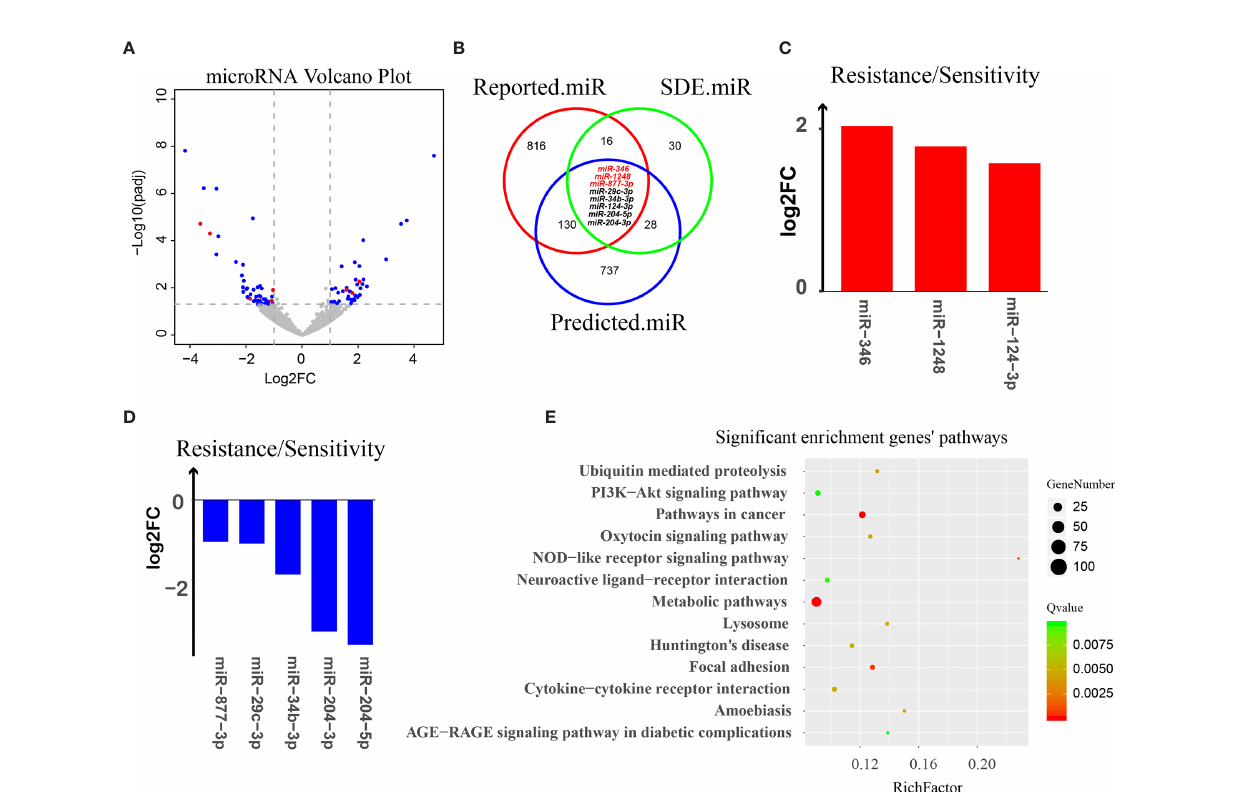
FIGURE 5 | Analysis of miRNA targeting of circRNAs. (A) Volcano plot of all miRNAs. The X-axis represents the log 2 (fold-change) of miRNA between docetaxel- resistant cells and -sensitive cells. The Y-axis represents the -log 10 (P value) of the differential expression between the two groups. Blue dots represent miRNAs that were SDE by the two groups. Red dots represent the 8 eligible miRNAs. (B) A three-way Venn diagram representing the intersection of 3 miRNA groups: the red cycle represents miRNAs that may relate to chemotherapy reported in PubMed, the green cycle represents SDE miRNAs in our data, and the blue cycle represents miRNAs predicted to target the 3 potentially chemotherapy-resistant circular RNAs, miRNAs predicted by at least three software tools are indicated by red letters. (C, D) Log 2 (fold-change) of 8 eligible miRNAs. (E) KEGG pathway enrichment for the target genes of the 8 eligible